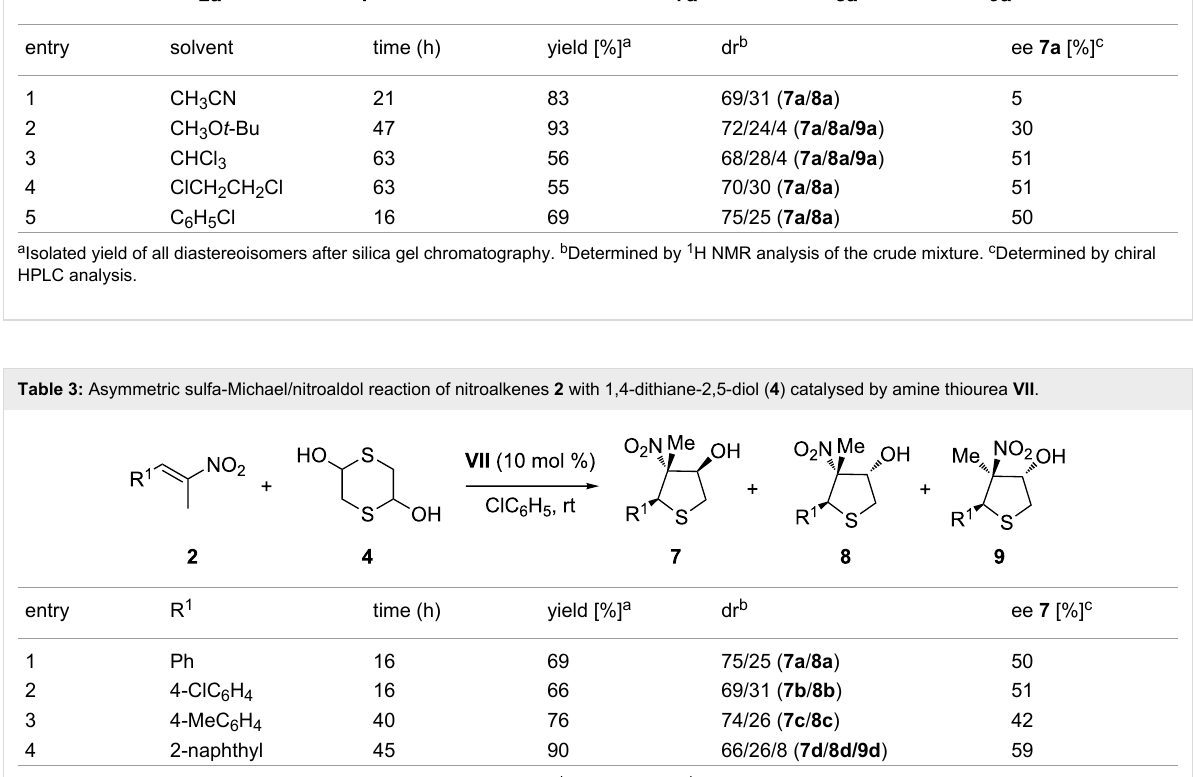
a Isolated yield of all diastereoisomers after silica gel chromatography. b Determined by 1 H NMR analysis of the crude mixture. c Determined by chiral HPLC